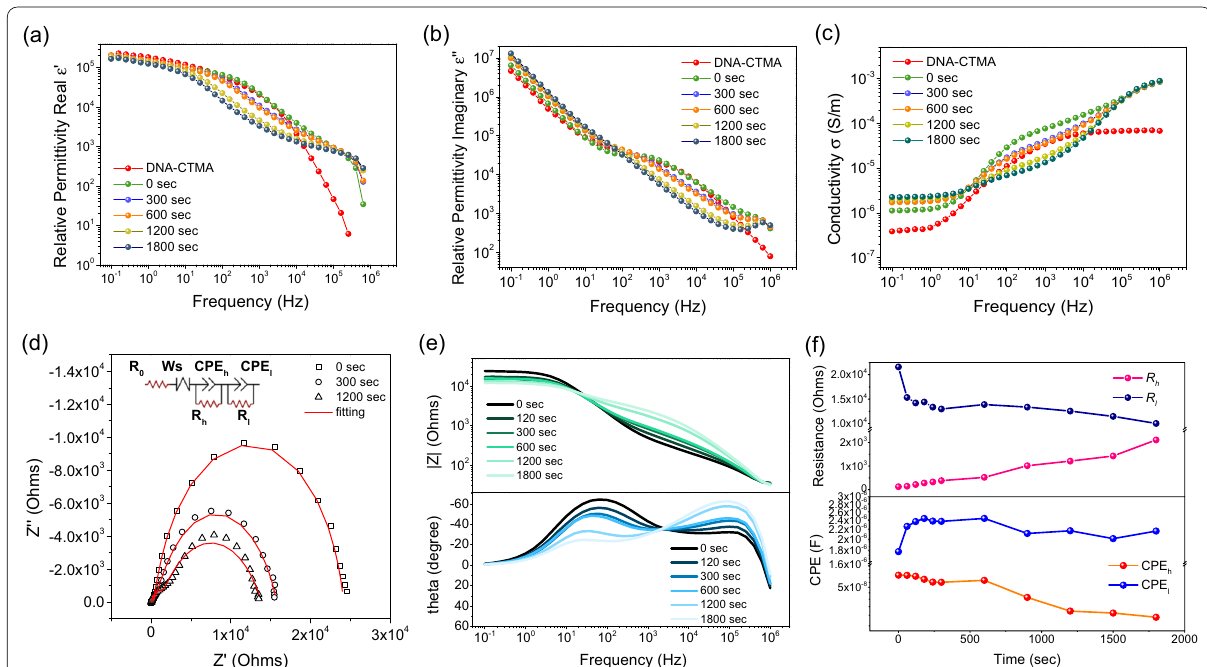
Fig. 4 The real part ( a ) and imaginary part ( b ) of the dielectric permittivity for the pristine DNA‑CTMA and DNA‑CTMA‑Ag with varied UV irradiation times c Conductivities of the DNA‑CTMA‑Ag with varied UV irradiation times d The Cole‑Cole plot of DNA‑CTMA‑Ag with varied UV irradiation times e The Bode plot of DNA‑CTMA‑Ag ( f ) Fitting parameters of the circuit model in the inset of